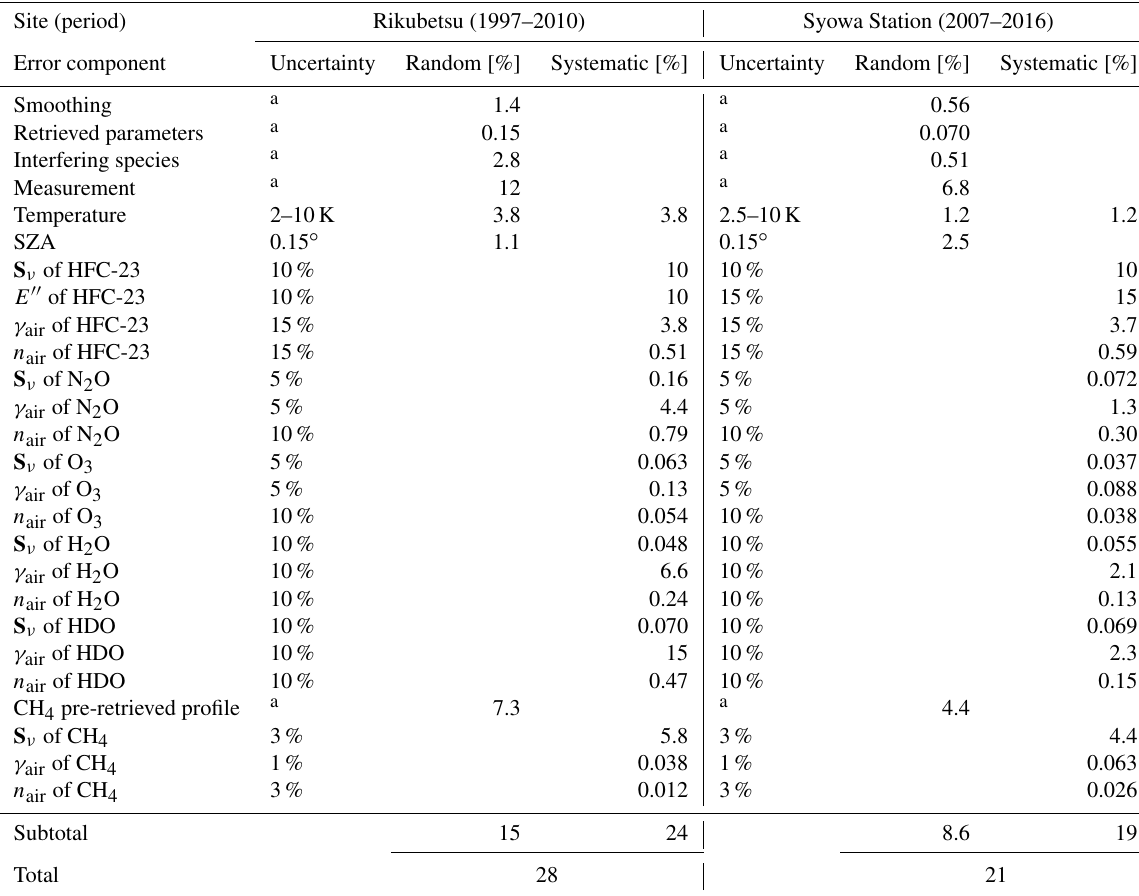
Table 4. Mean random and systematic errors as well as uncertainties in FTIR-retrieved HFC-23 total columns at Rikubetsu and Syowa